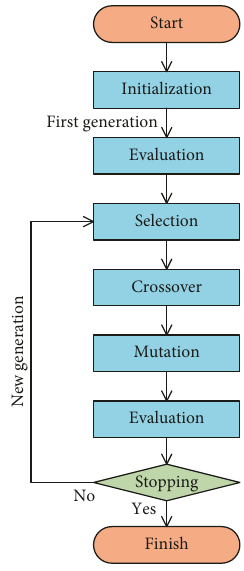
Figure 1: Traditional genetic algorithm flow